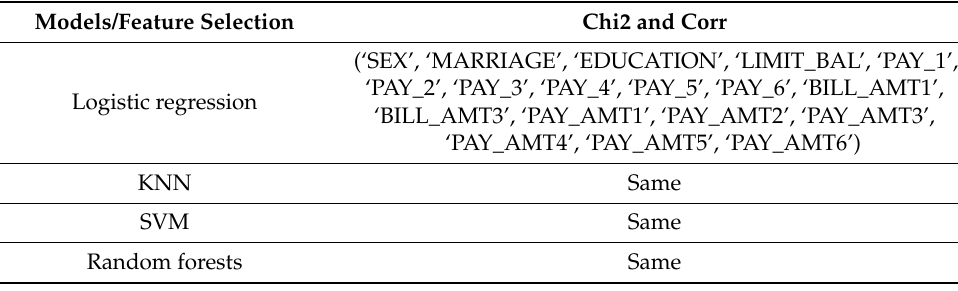
Figure 6. The change in the model simplicity (no. of features). Table 4. The features selected by the Chi-squared test and correlation coefficient.